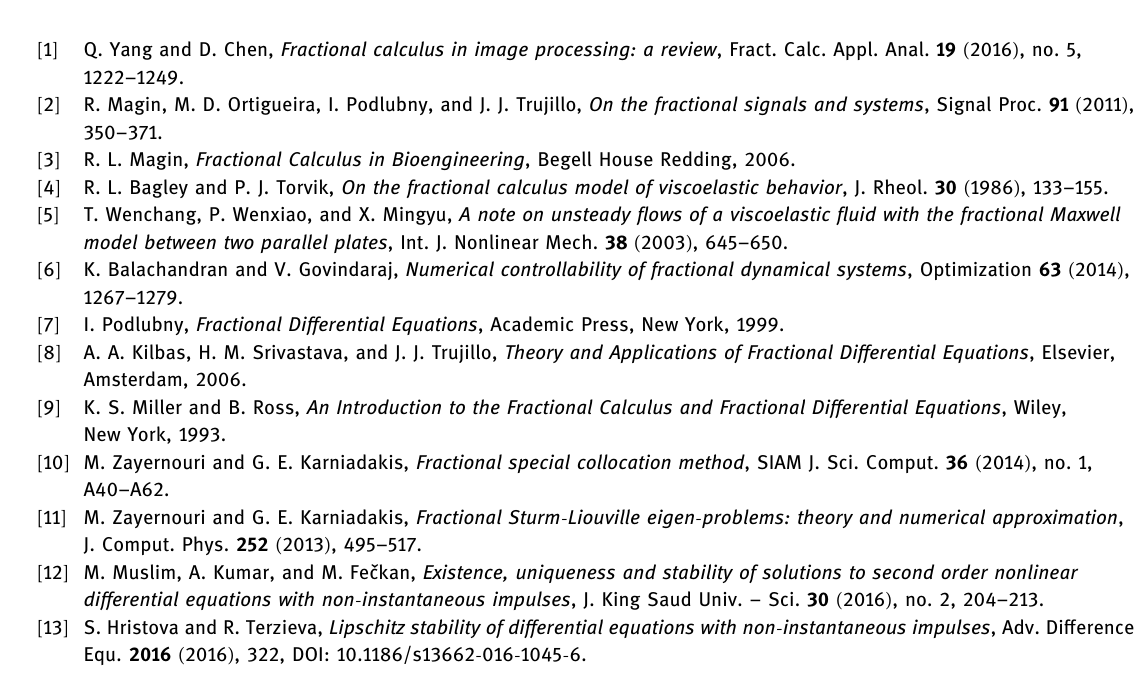
Figure 6: The trajectory of the nonlinear system ( 6.4 ) steers the initial state intervals 0, 1